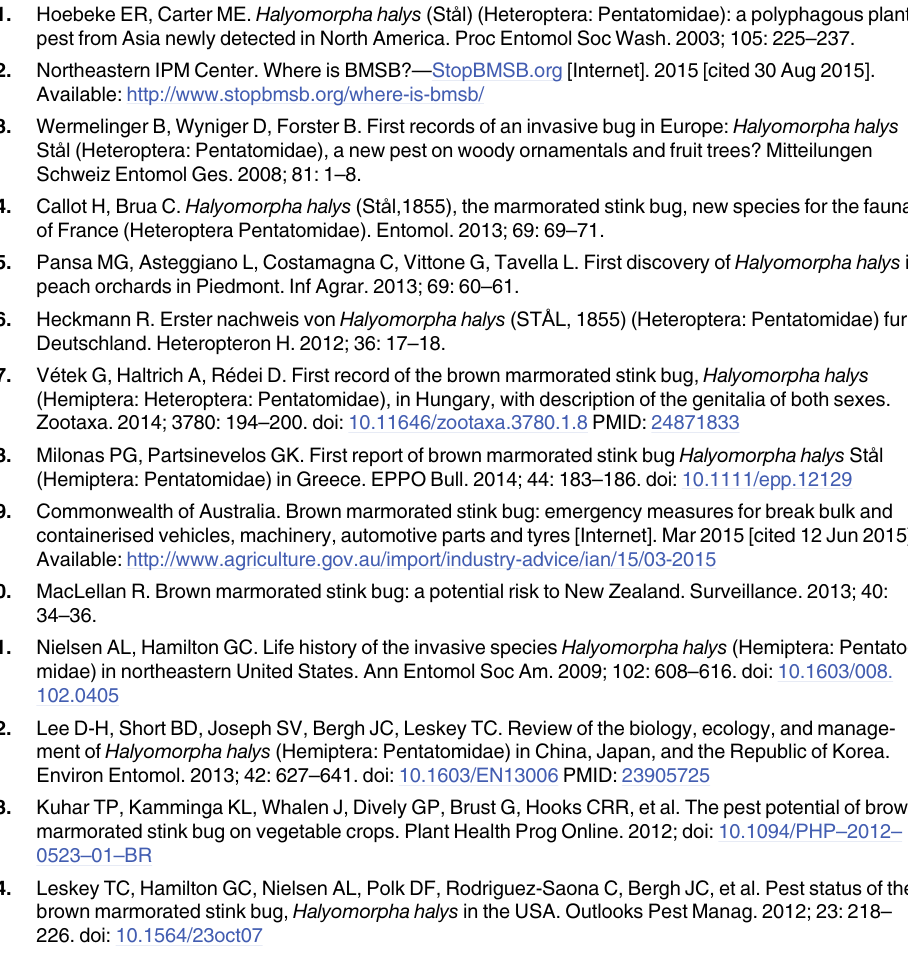
S2 Table. Host utilization by Halyomorpha halys in our study in comparison with existing